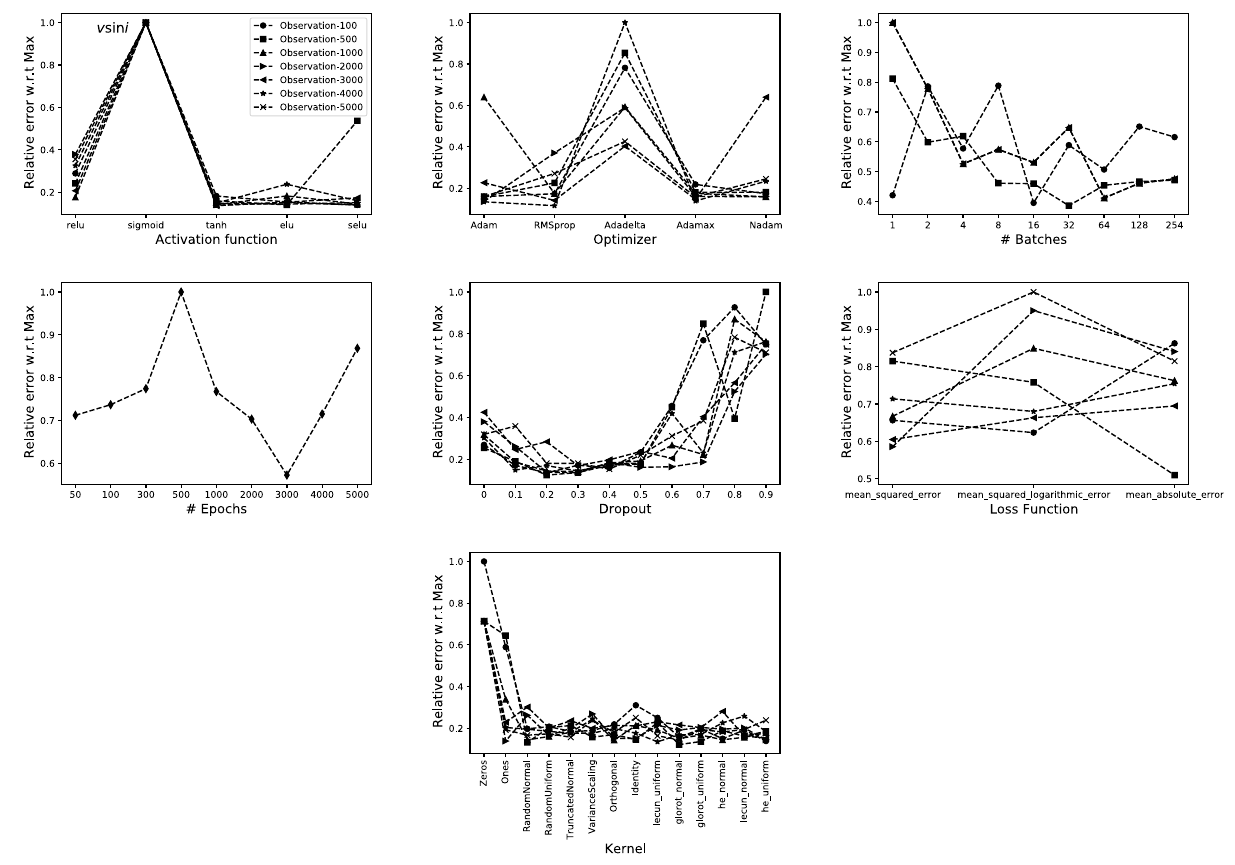
Figure 8: Same as Figure 5 but for v i sin e